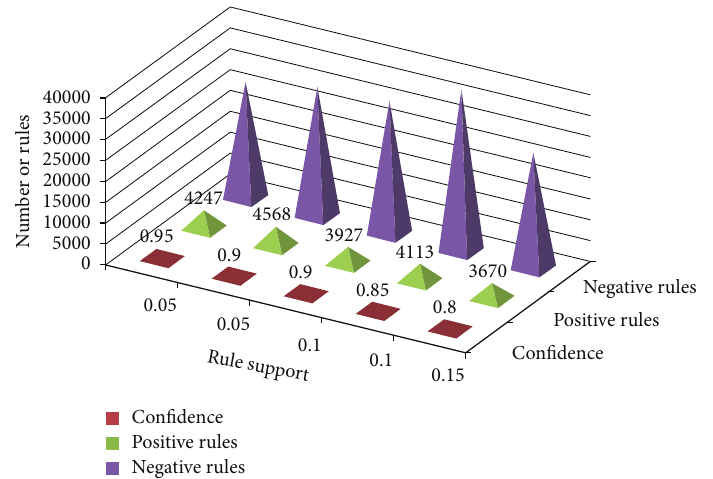
Figure 2: Positive and negative rules generated with varying minimum supports and confidence